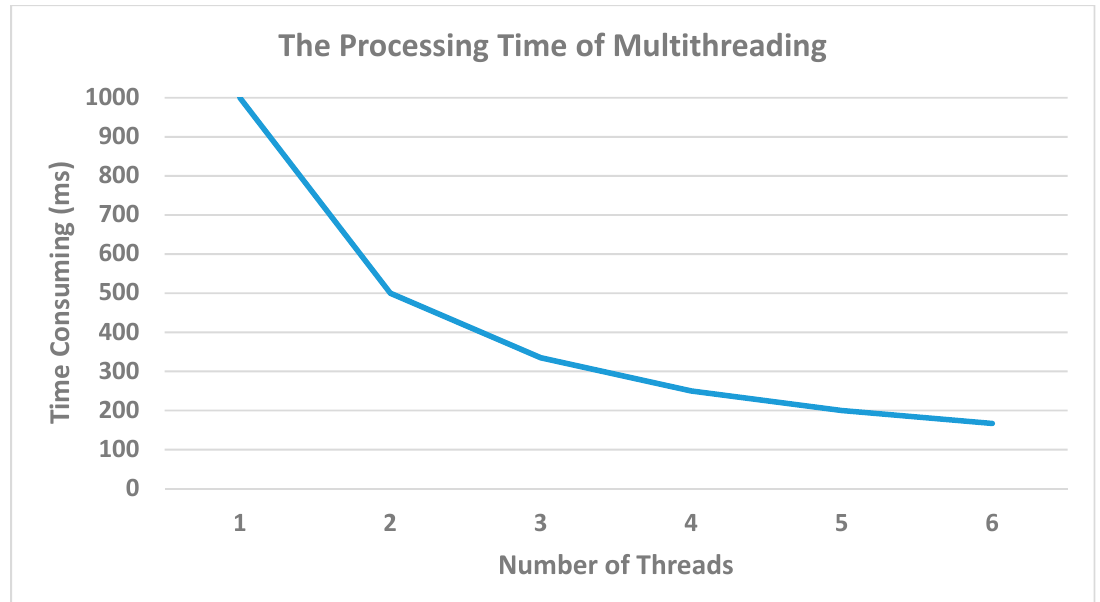
Figure 14. Using Multithreading in Kafka Consumers to reduce the time-consuming.